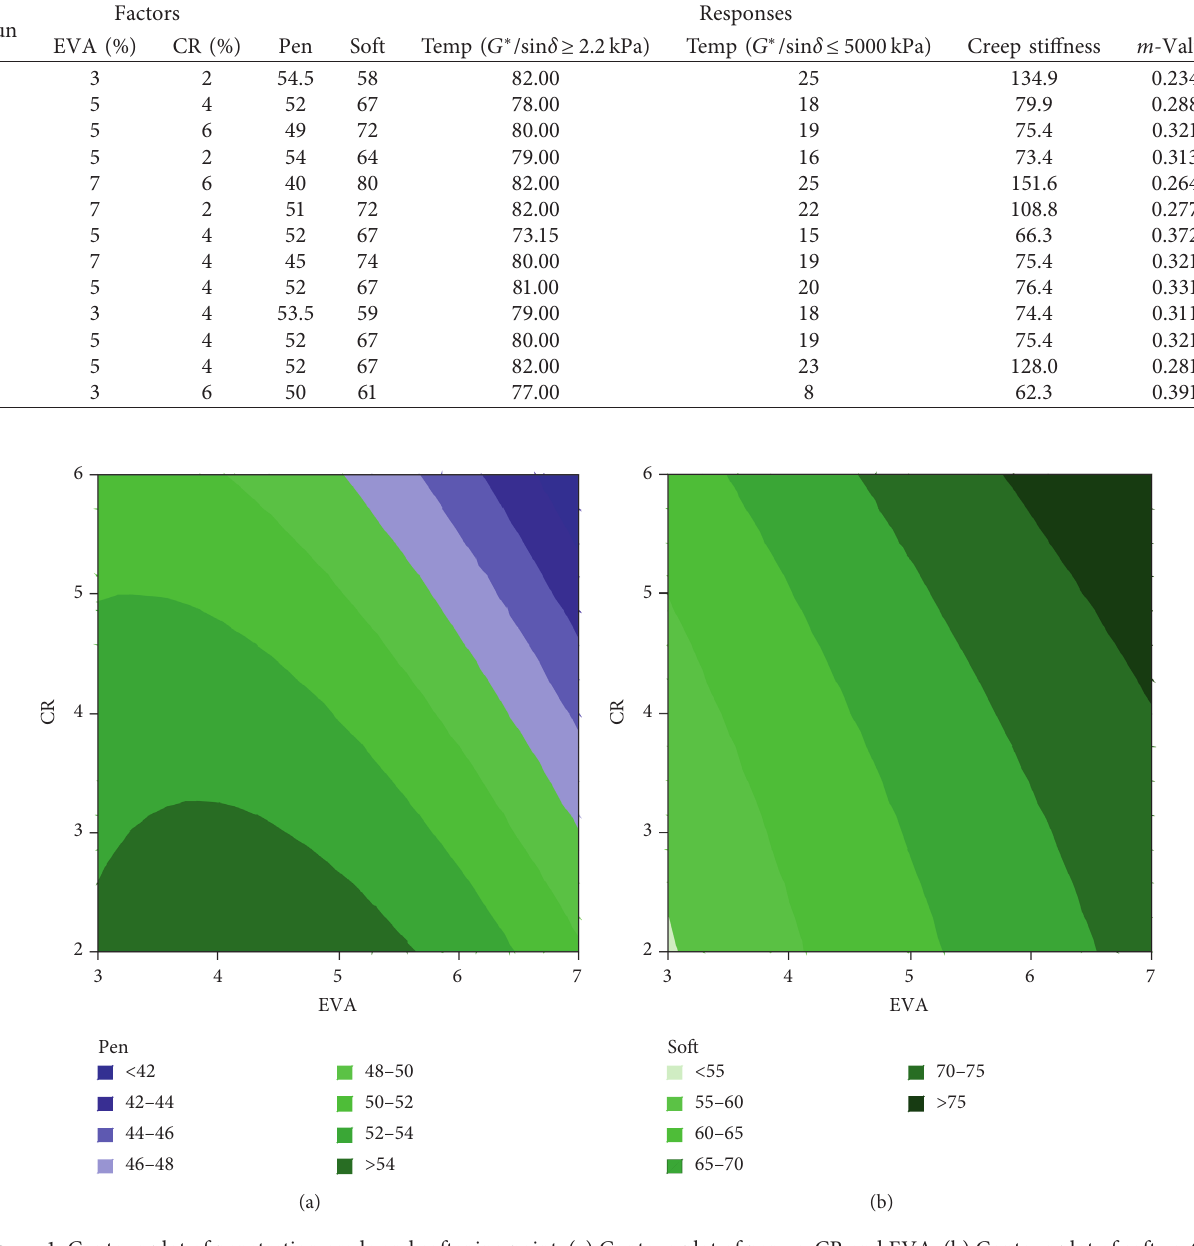
Table 2: Central composite design arrangement and responses.